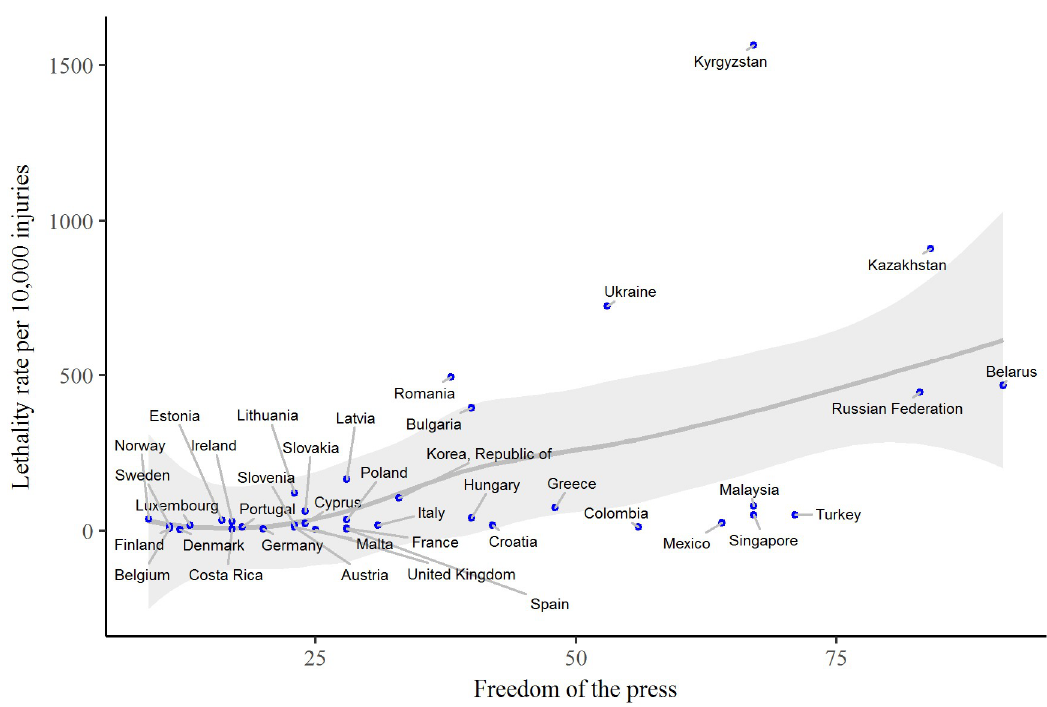
Figure 4. Freedom of the press and lethality rate per 10,000 occupational injuries of 39 countries in 2015. Note: All data sourced from International Labour Organization Database (ILOSTAT) [18] and Freedom House [23]. The grey line indicates the smooth nonparametric curve using a loess smoother (the loess span 0.75) and the grey shadow indicates the 95% confidence interval of smoothed curve.